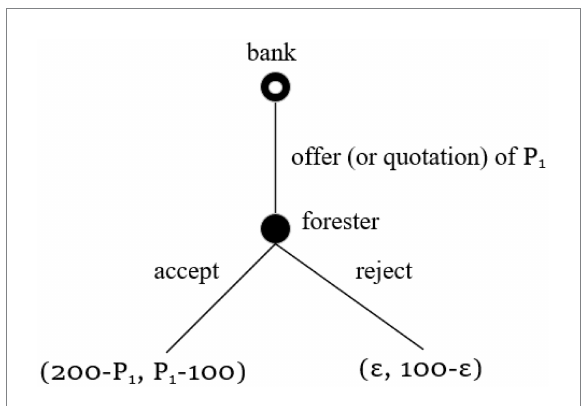
FIGURE 3 Solving for the game equilibrium using backward induction.